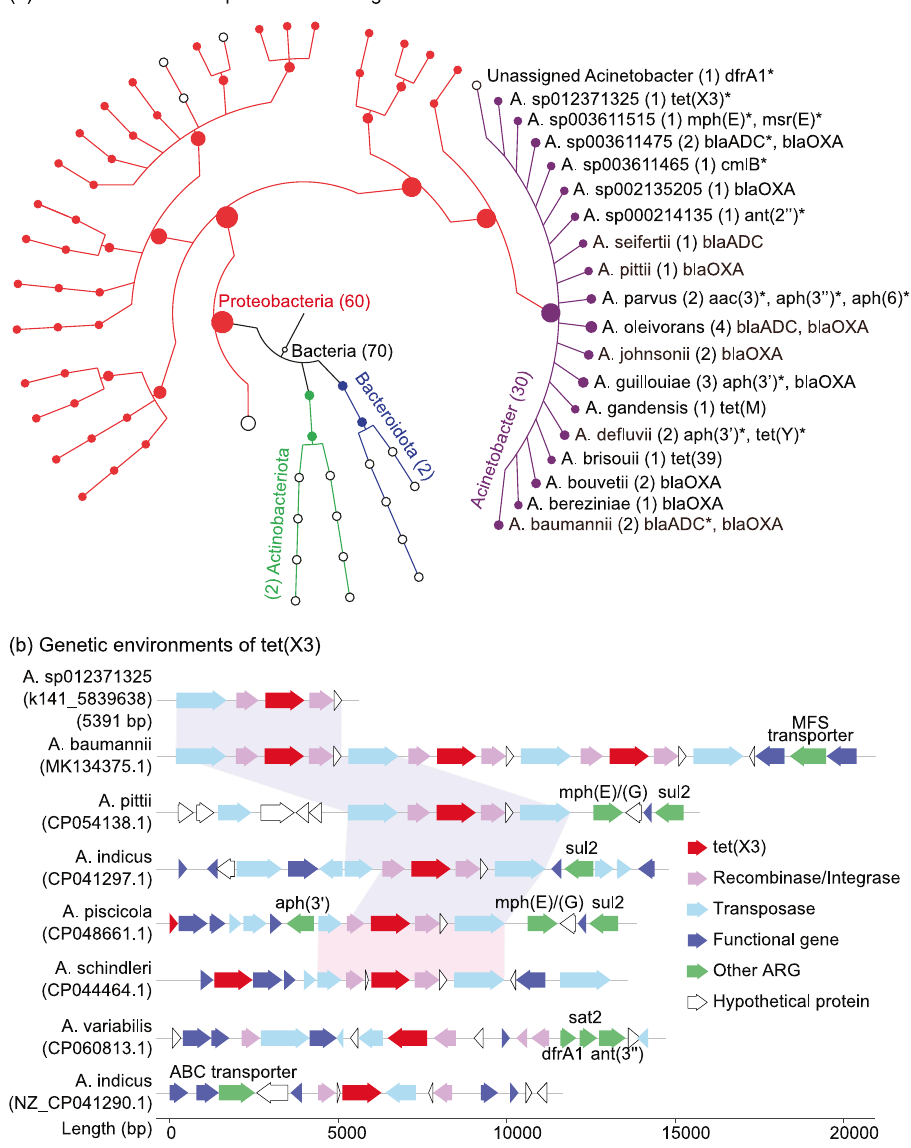
Fig. 3 Pro fi les of acquired ARGs in the groundwater. a Potential hosts of the contigs in the groundwater. Values in brackets are contig numbers. Asterisk-marked ARGs mean that there were MGEs colocalized. b Genetic environments of tet (X3)-contig in the published Acinetobacter species. The accession number of each species is given in the bracket. Genes in a shadow have the same genetic